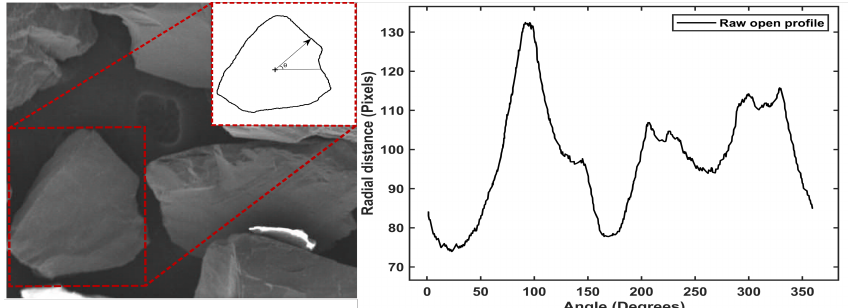
Figure 1: a) Raw boundary of a sand particle extracted from SEM image and b) Raw open